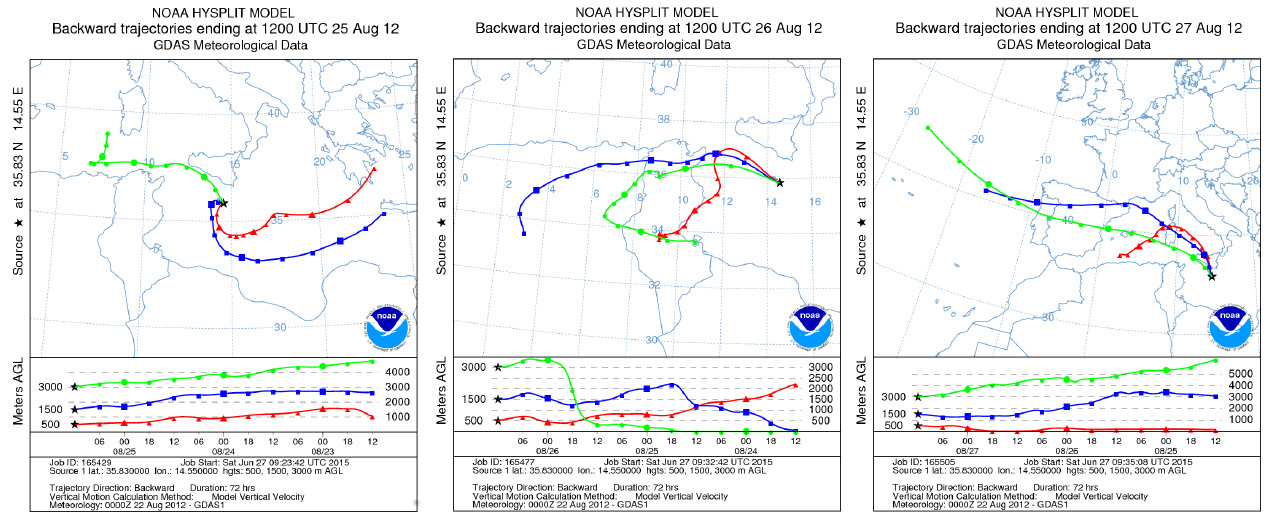
Figure 3. Air-mass backward trajectories at 500, 1500 and 3000m a.g.l. obtained from NCEP/NCAR reanalysis data and HYSPLIT model at Marsaxlokk in the period 25–27 August 2012.